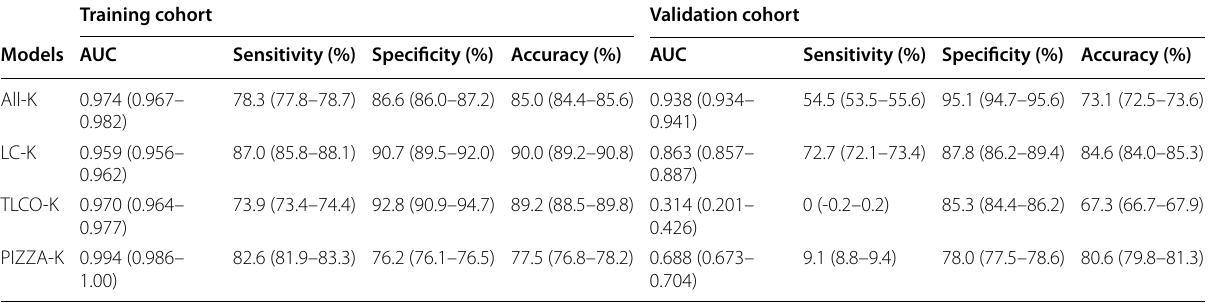
Data in parentheses are 95% confidence